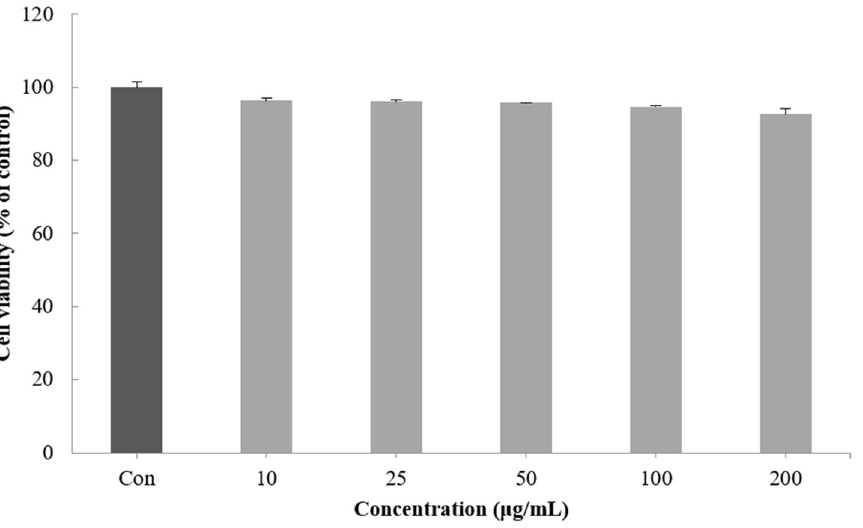
Figure 2. Effect of CGCS extracts on viability of B16F10 melanoma cells. Cells were treated with 10– 200 µg/mL CGCS extracts for 72 h. Data are expressed as mean ± SD of three independent